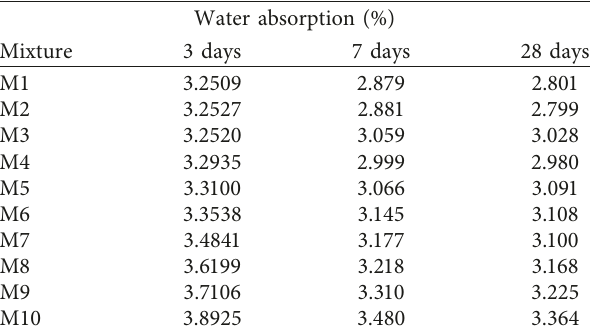
Table 4: Water absorption values of SCC series.